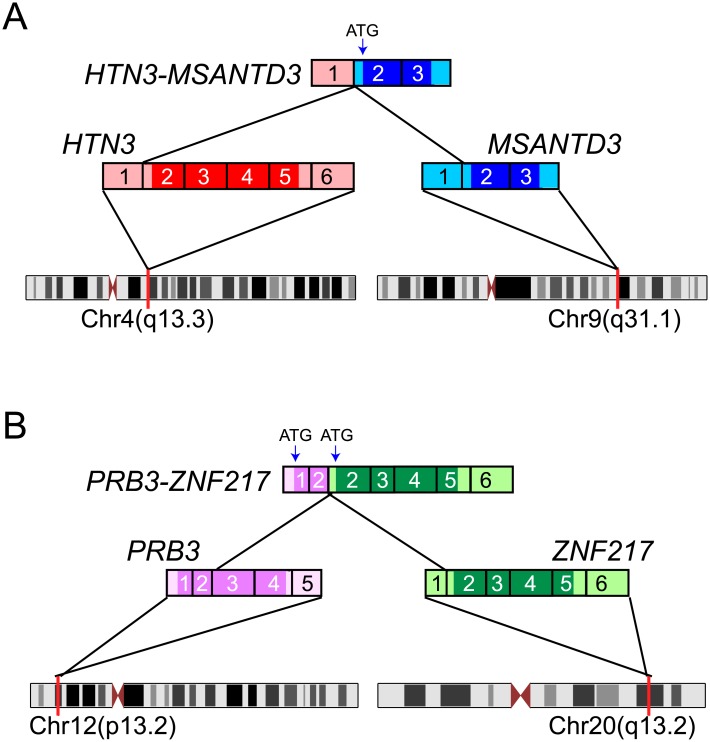
Novel genes fusions in acinic cell carcinoma.(A) Predicted structure of the HTN3-MSANTD3 fusion gene. Exon 1 (non-coding) of HTN3 is fused to the exon 2 (first coding exon) of MSANTD3, leading to predicted overexpression of full-length MSANTD3 protein (translation start site is indicated). Fusion junction-spanning sequence reads are shown in S1 Fig. (B) Predicted structure of the PRB3-ZNF217 gene fusion. Here, exon 2 (coding) of PRB3 is fused to exon 2 (first coding) of ZNF217, possibly leading to the overexpression (by internal initiation of translation) of full-length ZNF217 protein. Fusion junction-spanning sequence reads are shown in S2 Fig.